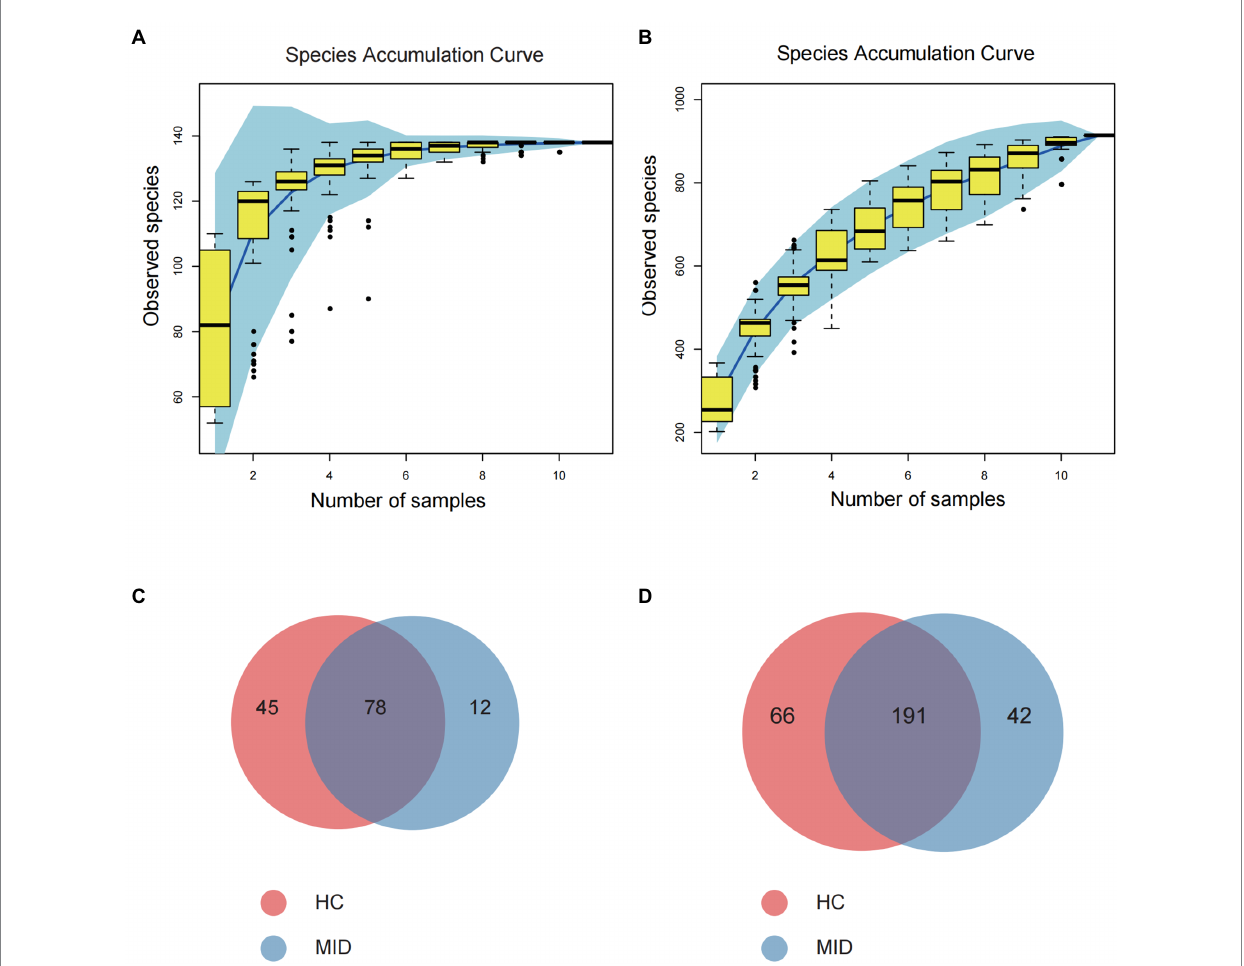
FIGURE 2 Rationality test of sample number and component difference statistics. Rarefaction Curve, horizontal axis is the number of sequencing strips randomly selected from a sample, and vertical axis is the number of OTU that can be constructed based on the number of sequencing strips, which is used to reflect the sequencing depth. The results showed that with the increase of the sample size, the number of OTU in the gut cavity (A) and oral cavity (B) gradually stabilized, indicating that the sampling number was reasonable. Venn diagram (C,D) showing significantly differential OTU between healthy control (HC) and meningitis-like infectious disease (MID). (C) Shows intestinal results and (D) shows oral results.